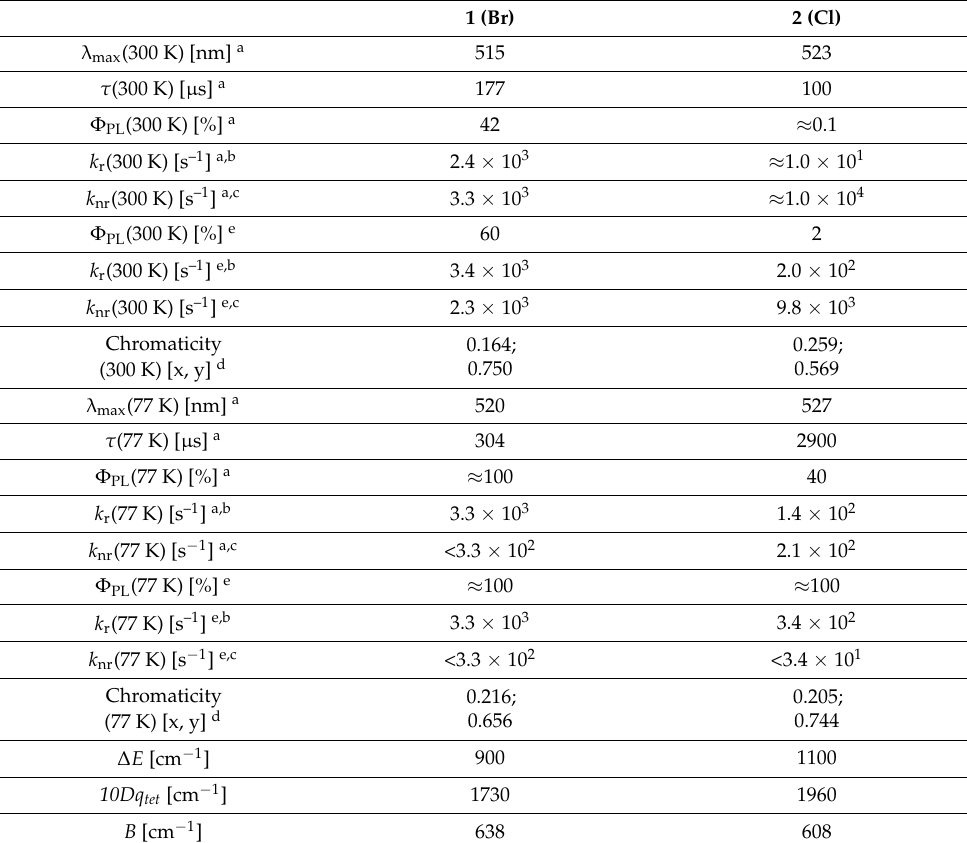
Table 2. Photophysical data for polycrystalline complexes 1 and 2